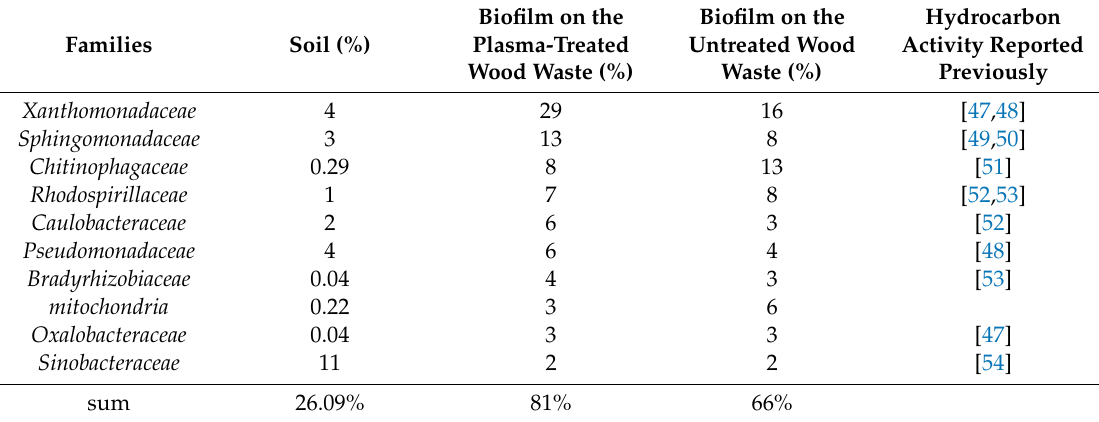
Table 1. Bacterial relative distribution at the family level of the top 10, relative to all identified families in the original diesel contaminated soil, within the biofilm grown on the plasma-treated and untreated wood